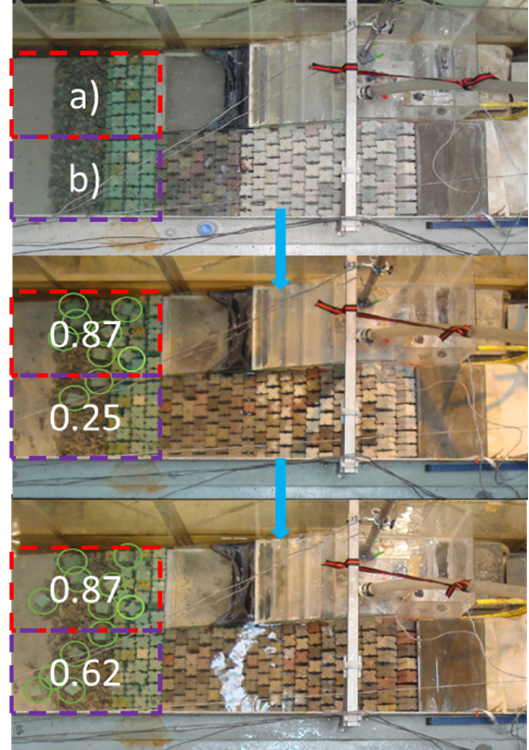
Figure 12. N od values for the extreme sea-state tests with the WEC integrated in the breakwater, for the area: ( a ) in front of the WEC and ( b ) adjacent to the WEC, going from the initial MLWS to the final MHWS test.